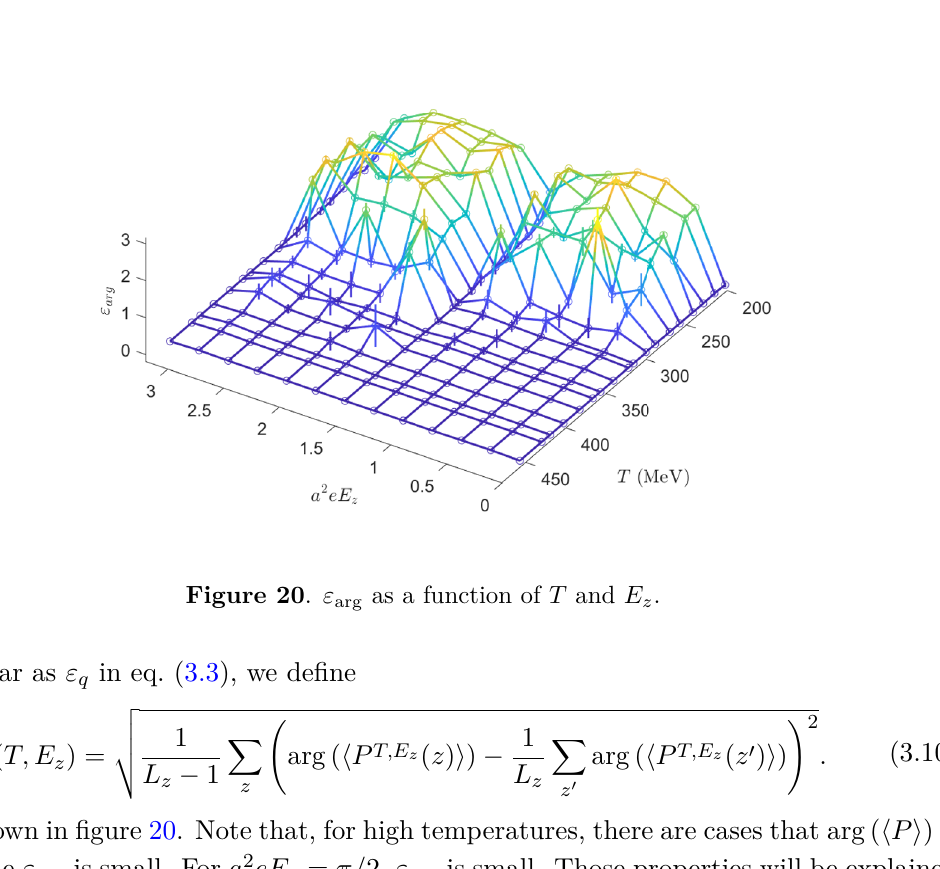
Figure 19 . h P ( z ) i at a 2 eE z = π/ 12 shown in the complex plane for β = 5 . 3 (the left panel) and β = 5 . 64 (the right panel).